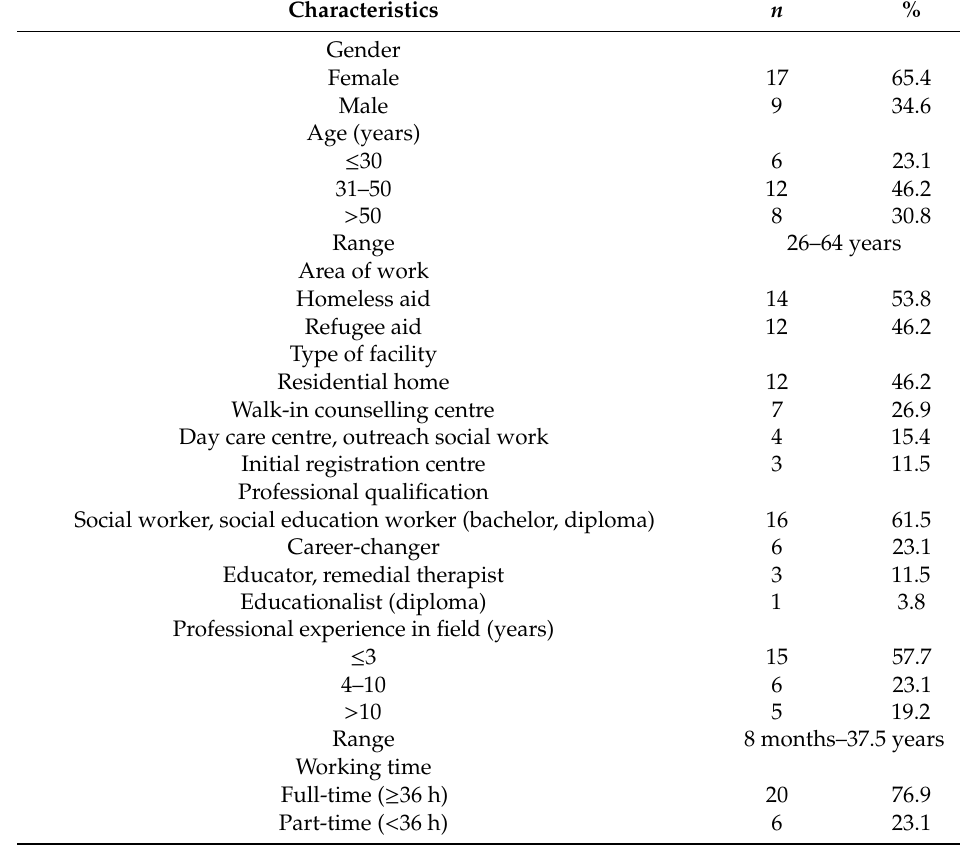
Table 1. Characteristics of study participants ( n =